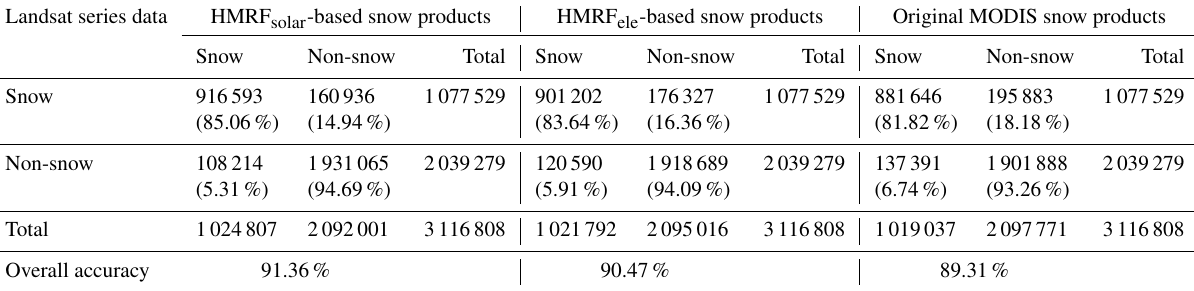
Table 3. Confusion matrices between HMRF solar -based snow products, HMRF ele -based snow products, original MODIS snow products, and snow cover mapped from Landsat series data products for gap-free pixels during 2002–2021.